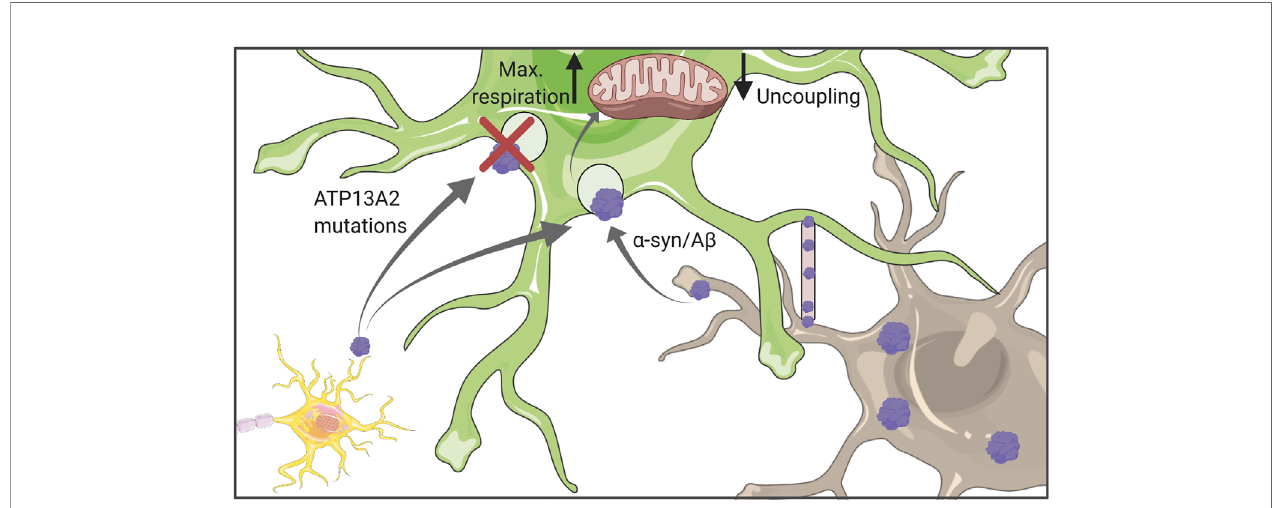
FIGURE 3 | Astrocytic uptake of protein aggregates. Astrocytes can internalize both A b and a -synuclein which might originate either from other astrocytes or neurons. Uptaken aggregates were shown to affect mitochondrial function, in particular their respiration capacity and coupling status. Figure created